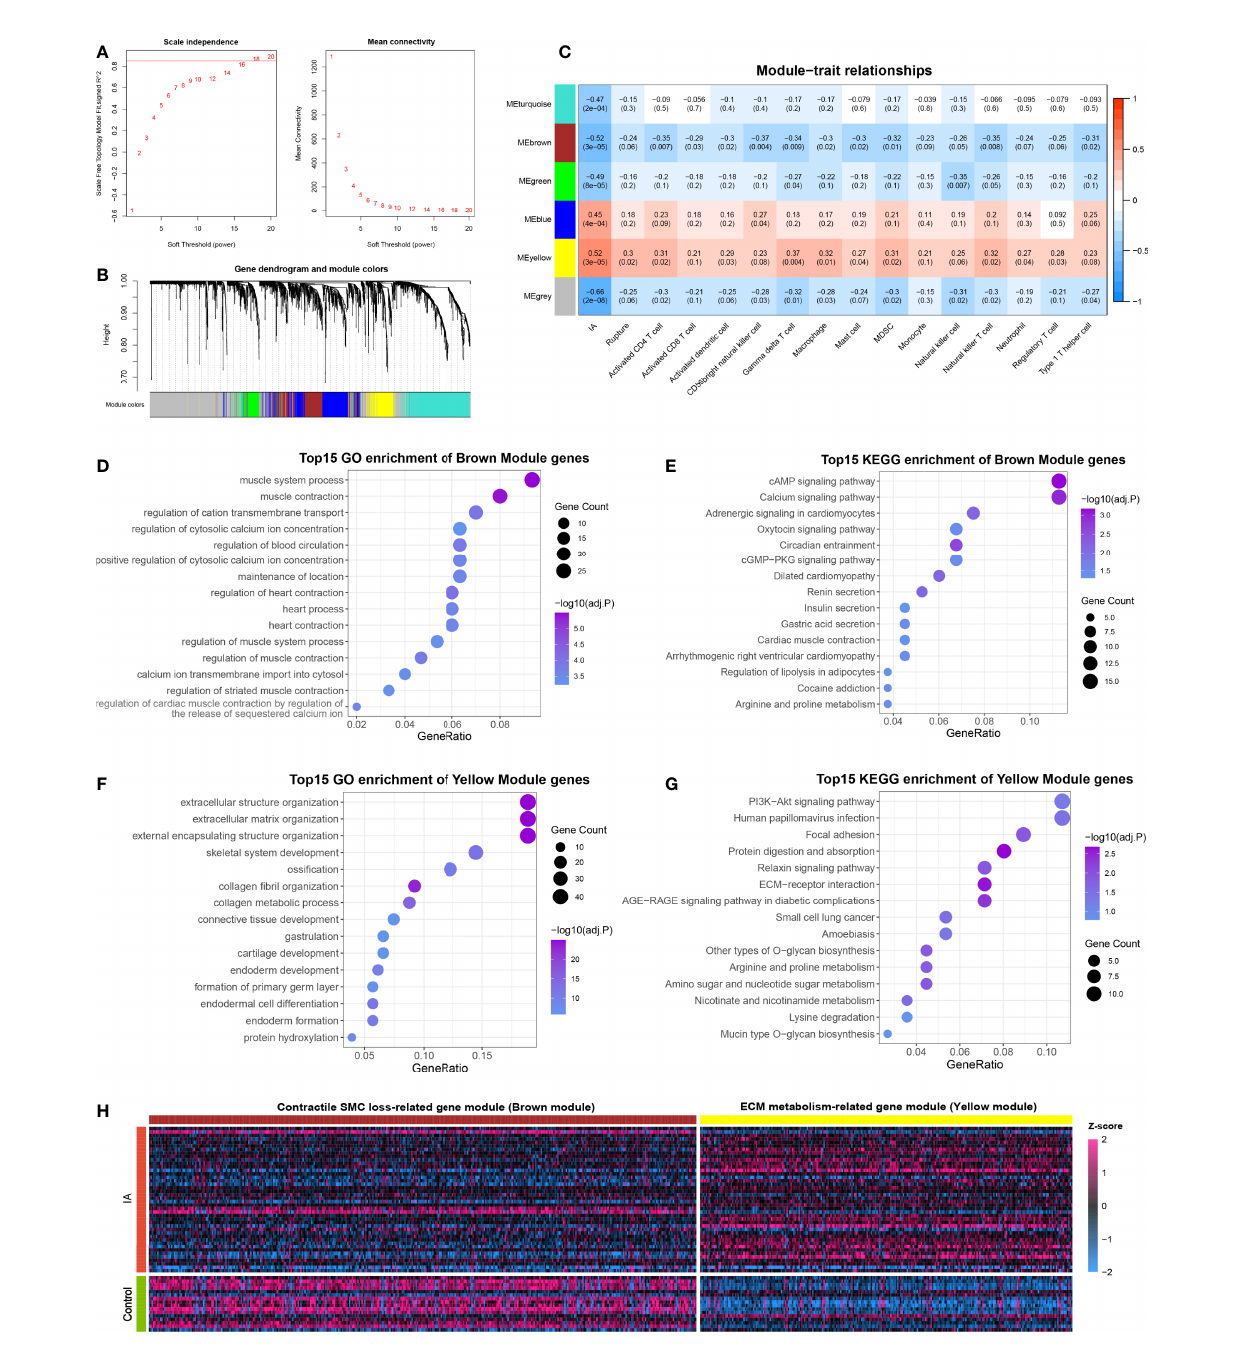
FIGURE 5 | Functional gene co-expression modules are recognized by WGCNA. (A) Determination of the soft-thresholding. (B) Gene clustering and co-expression module recognition. (C) Heatmap of the association of gene modules with IA, rupture status, and immune cell in fi ltration. (D, E). GO (D) and KEGG (E) enrichment analysis of brown module genes. (F, G). GO (F) and KEGG (G) enrichment analysis of yellow module genes. (H) Heatmap of DEGs in brown and yellow